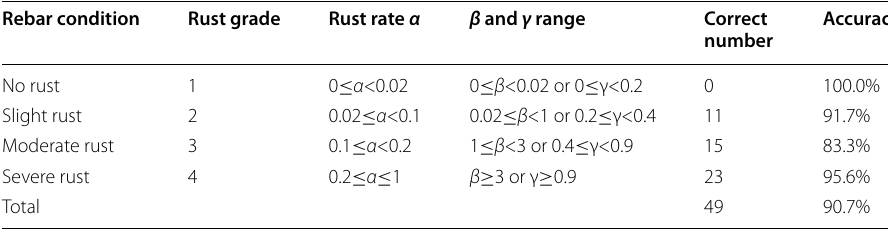
Table 9 Accuracy of model